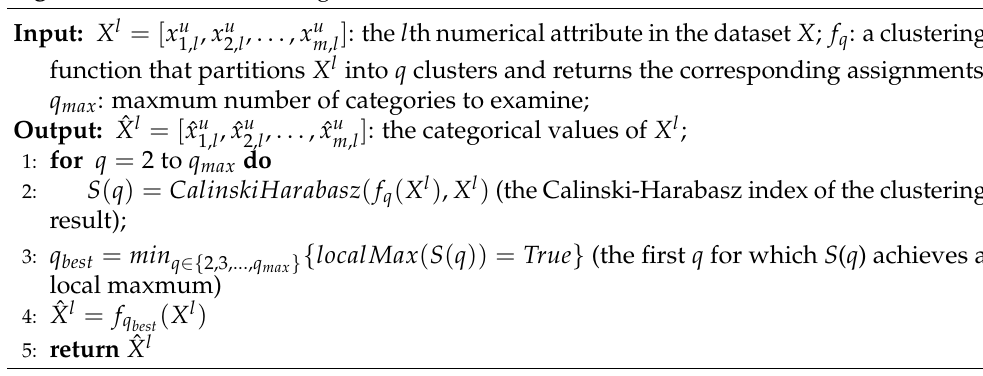
Figure 1. The Calinski-Harabasz index for q = 2,3, . . . ,100, the first local maxima of Calinski- Harabasz index is marked by the arrow. Algorithm 1 Automatic categorization for numerical